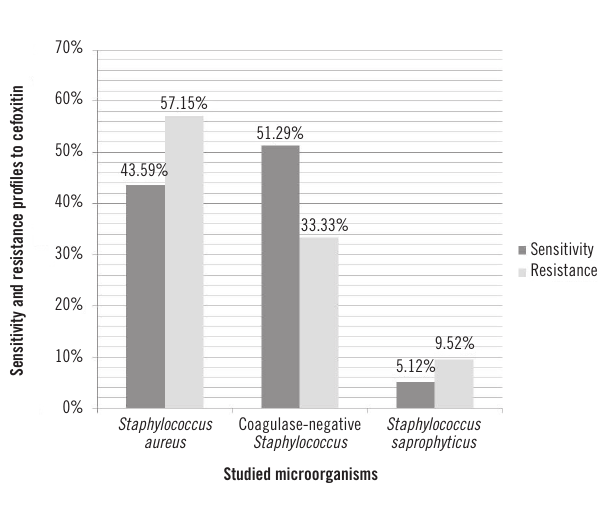
figurE 2 − Sensitivity and resistance profiles of Gram-positive strains to